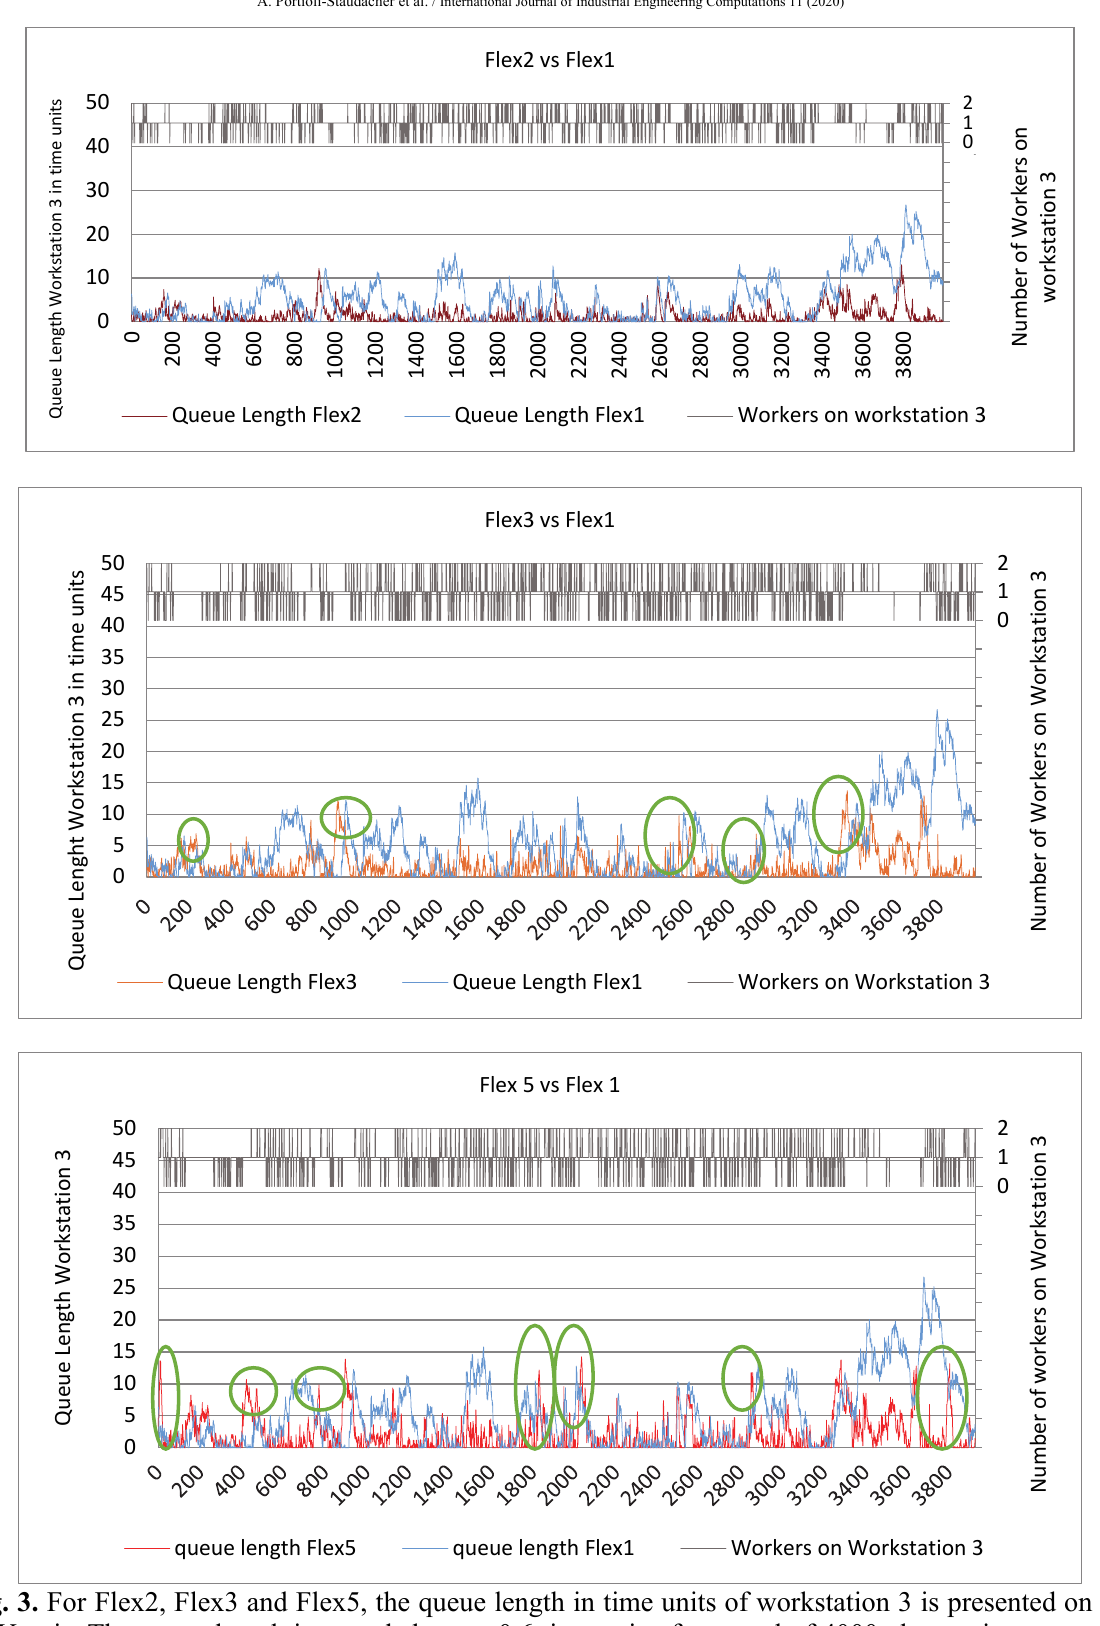
Fig. 3. For Flex2, Flex3 and Flex5, the queue length in time units of workstation 3 is presented on left Y-axis. The queue length is recorded every 0,6 time units, for a total of 4000 observations, reported on X-axis. In each graph on the right Y-axis the number of worker - that can be equal to 0 or 1 or 2 - on workstation 3 is presented. Flex1 is used as baseline in each